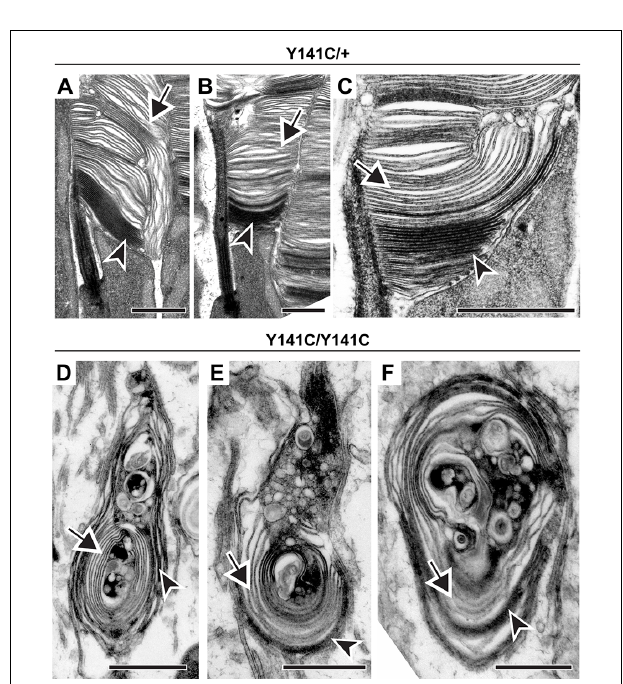
FIGURE 5 | Expression of Y141C PRPH2 disrupts outer segment structure without preventing disc enclosure. (A–C) TEM of photoreceptor outer segments of 90-day old heterozygous Y141C (Y141C/+) mice stained with tannic acid. (D–F) TEM of photoreceptor outer segments of 16-day old Y141C homozygous (Y141C/Y141C) mice stained with tannic acid. For each genotype, over 100 different outer segments from two mice were analyzed. For all images, arrowheads mark darkly stained open discs while arrows mark lightly stained enclosed discs. Scale bars are 1 µ m.